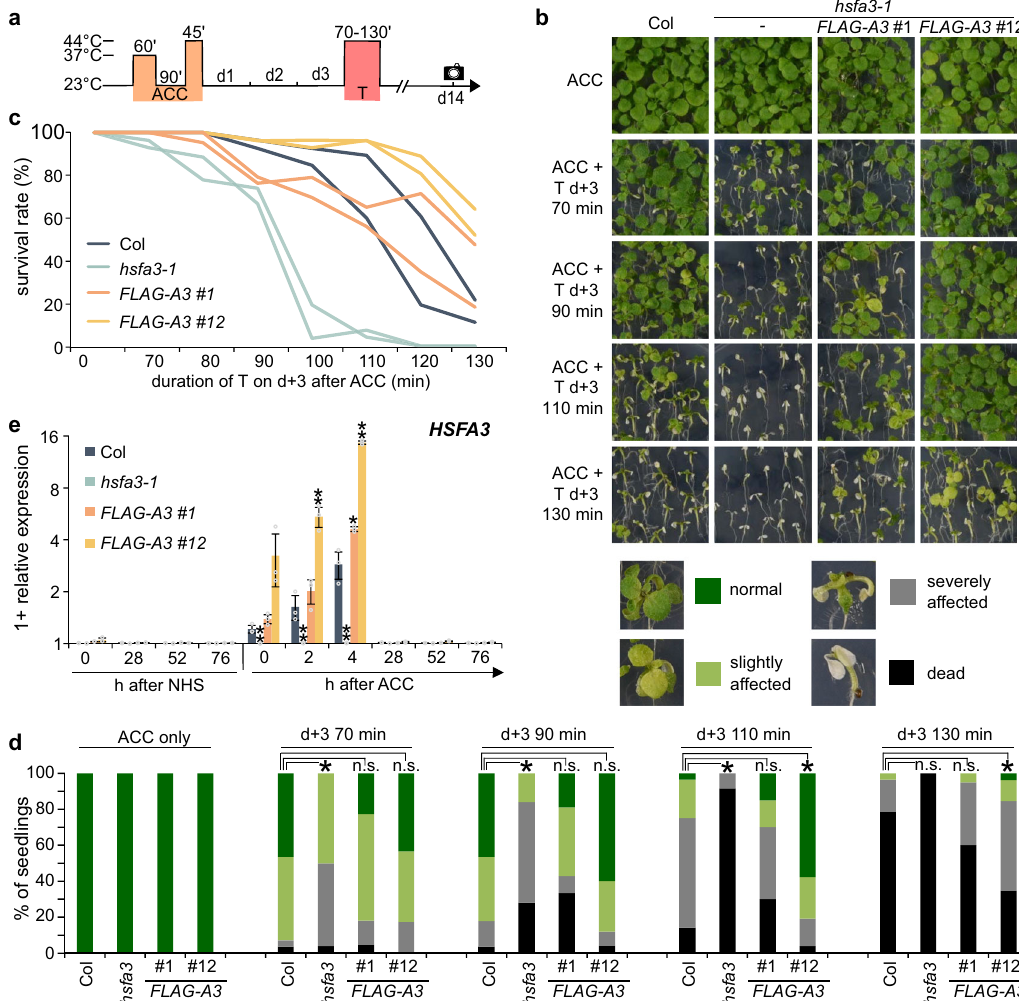
Fig. 2 FGT3 / HSFA3 is required for physiological HS memory. a Treatment scheme for HS memory assays: plants are exposed to a triggering HS (T, 44 °C for 70 – 130 min) 3 d after ACC (which was applied 4 d after germination) and survival is scored 14 d after ACC (black camera symbol). b – d HS memory assay of hsfa3-1 and two complementing lines of pHSFA3::FLAG-HSFA3 in the hsfa3-1 background. b Representative images of HS memory assay, with legend showing examples of phenotype categories used for the quanti fi cation in d . c Survival rates of the different genotypes in HS memory assay. Data are from 2 independent replicates with n ≥ 19 seedlings for each timepoint and genotype. d Distribution of phenotypic categories observed in the HS memory assay shown in b . Asterisks depict signi fi cant differences to Col ( p < 0.01, Fisher ’ s exact test, n ≥ 19 seedlings for each timepoint and genotype). e Transcript levels of HSFA3 in Col, hsfa3-1 and two pHSFA3::FLAG-HSFA3 lines in the hsfa3-1 background as measured by qRT-PCR. Expression values are relative to the At4g26410 reference gene, as in all following qRT-PCR fi gures. Data are mean ± SD of three independent experiments and asterisks indicate signi fi cant differences to Col (*, p < 0.05; **, p < 0.01; unpaired two-sided